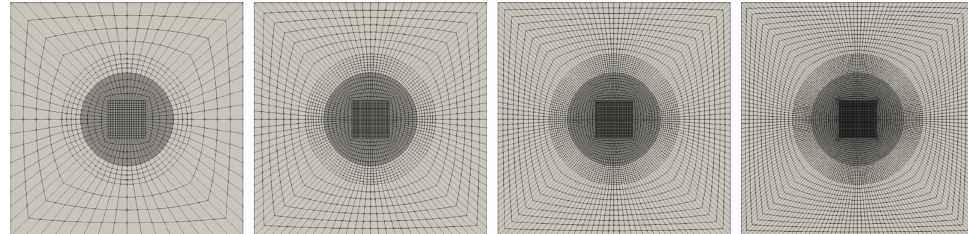
Figure 2: 2D: Meshes with 1024, 3136, 6400 and 10,816 elements (from left to right), inclusion highlighted in dark gray.